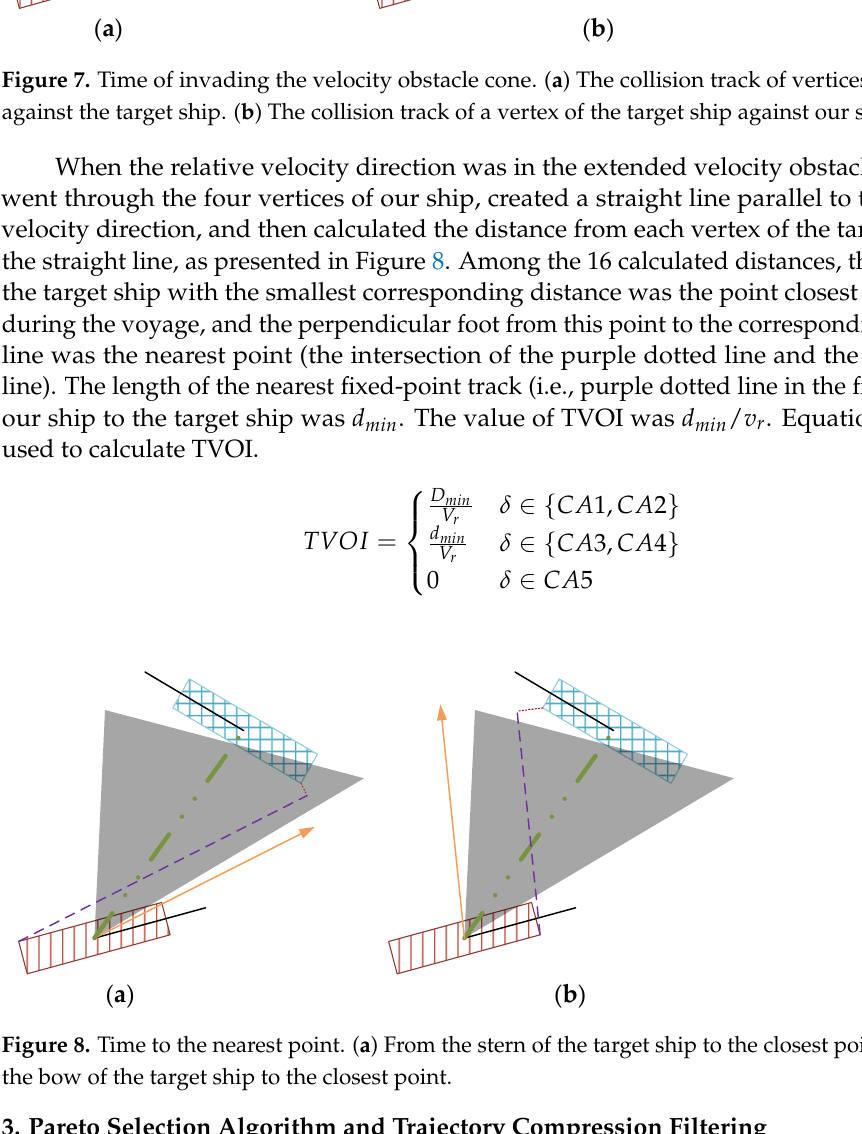
Figure 8. Time to the nearest point. ( a ) From the stern of the target ship to the closest point. ( b ) From the bow of the target ship to the closest point.